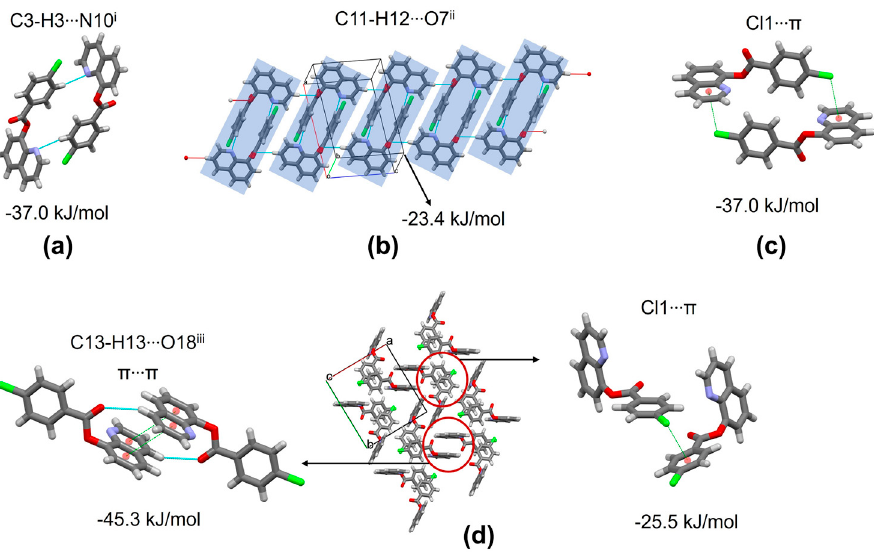
Figure 6. ( a ) C3-H3···N10i hydrogen bonds join pairs of inversion-related molecules. ( b ) C11- H12···O7ii hydrogen bonds helping in the formation of chains in the [001] direction. ( c ) Cl1··· π contacts. ( d ) π ··· π and C13-H13···O18iii interactions helping in the packing. The red circle shows contacts. ( d ) π ··· π and C13-H13 ··· O18 iii interactions helping in the packing. The red circle shows pairwise interaction energies. pairwise interaction